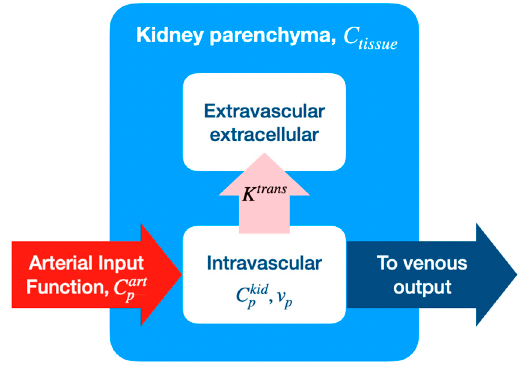
Figure 1. Schematic illustration of the two-compartment filtration model.